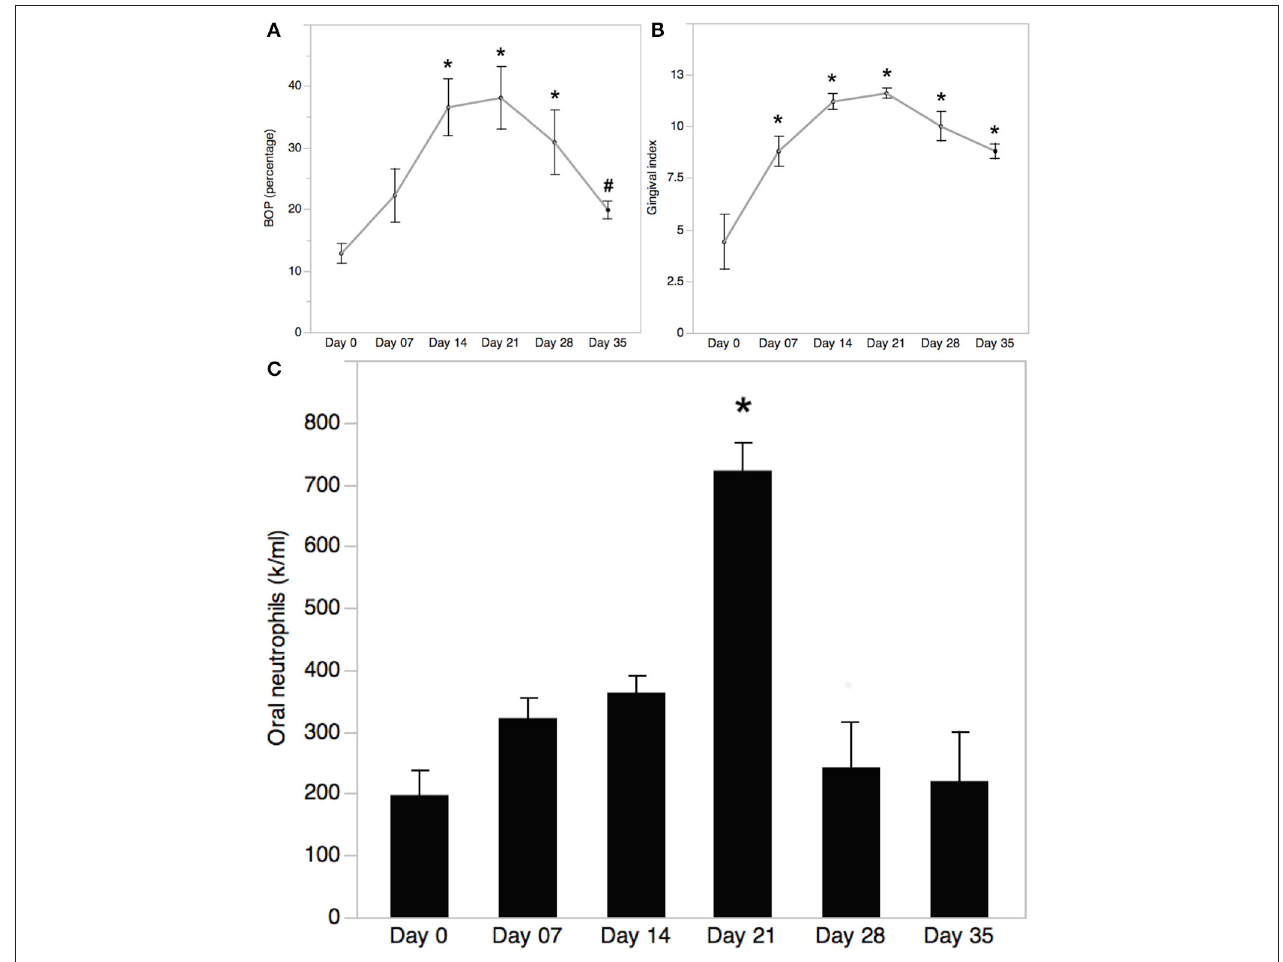
FIGURE 2 | Bleeding on Probing (BOP) trend in experimental gingivitis. (A) Bleeding on probing (BOP) was measured at baseline (day 0) and on days 7, 14, 21, 28, and 35 during EG. Mean ± SEM; n = 5 ; One-way ANOVA with Turkey-Kramer HSD, * p < 0.05 vs. day 0, # p < 0.05 vs. day 21. (B) Gingival index was measured at baseline (day 0) and on days 7, 14, 21, 28, and 35 during EG. Mean ± SEM; n = 5 ; One-way ANOVA with Turkey-Kramer HSD, * p < 0.05 . (C) Oral neutrophils isolated from oral rinses collected on days 0, 7, 14, 21, 28, and 35 of EG were quantified using a hemocytometer. Cell numbers were normalized to the rinse volume collected. Mean ± SEM; n = 5 ; One-way ANOVA with Turkey-Kramer HSD; * p < 0.05 .